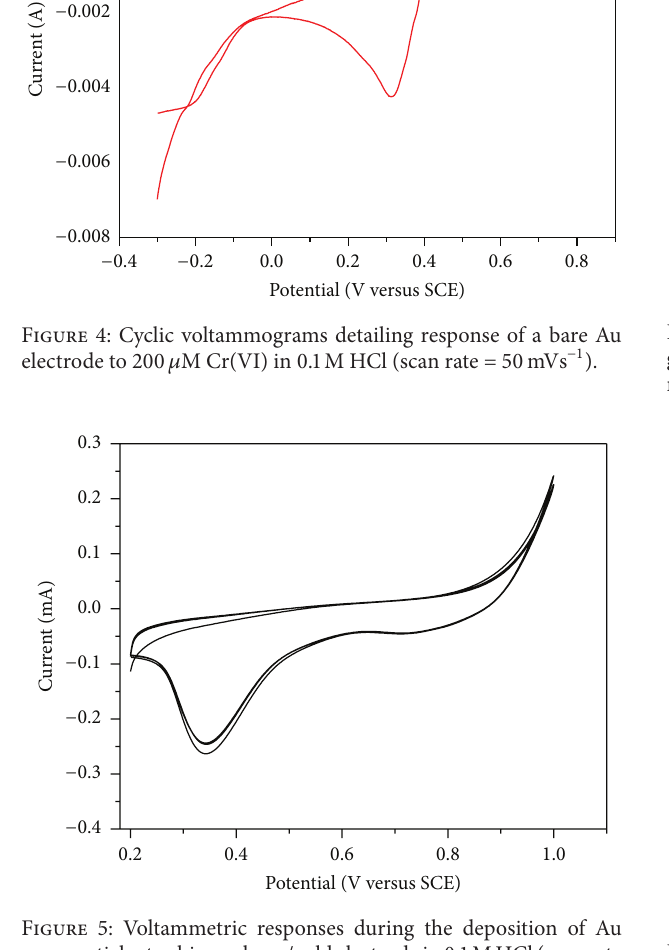
Figure 7: Cyclic voltammograms detailing the response to different scan rates (10–400mVs −1 ) for the solution containing 50 𝜇 M Cr(VI) in 0.1 M HCl at a modified Au